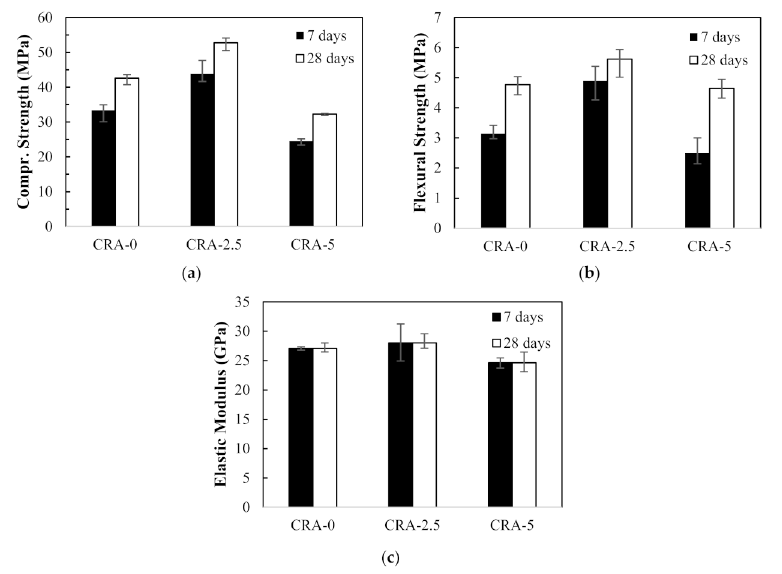
Figure 6. Mechanical strength results of first mix series: ( a ) compressive strength, ( b ) flexural strength, and ( c ) elastic